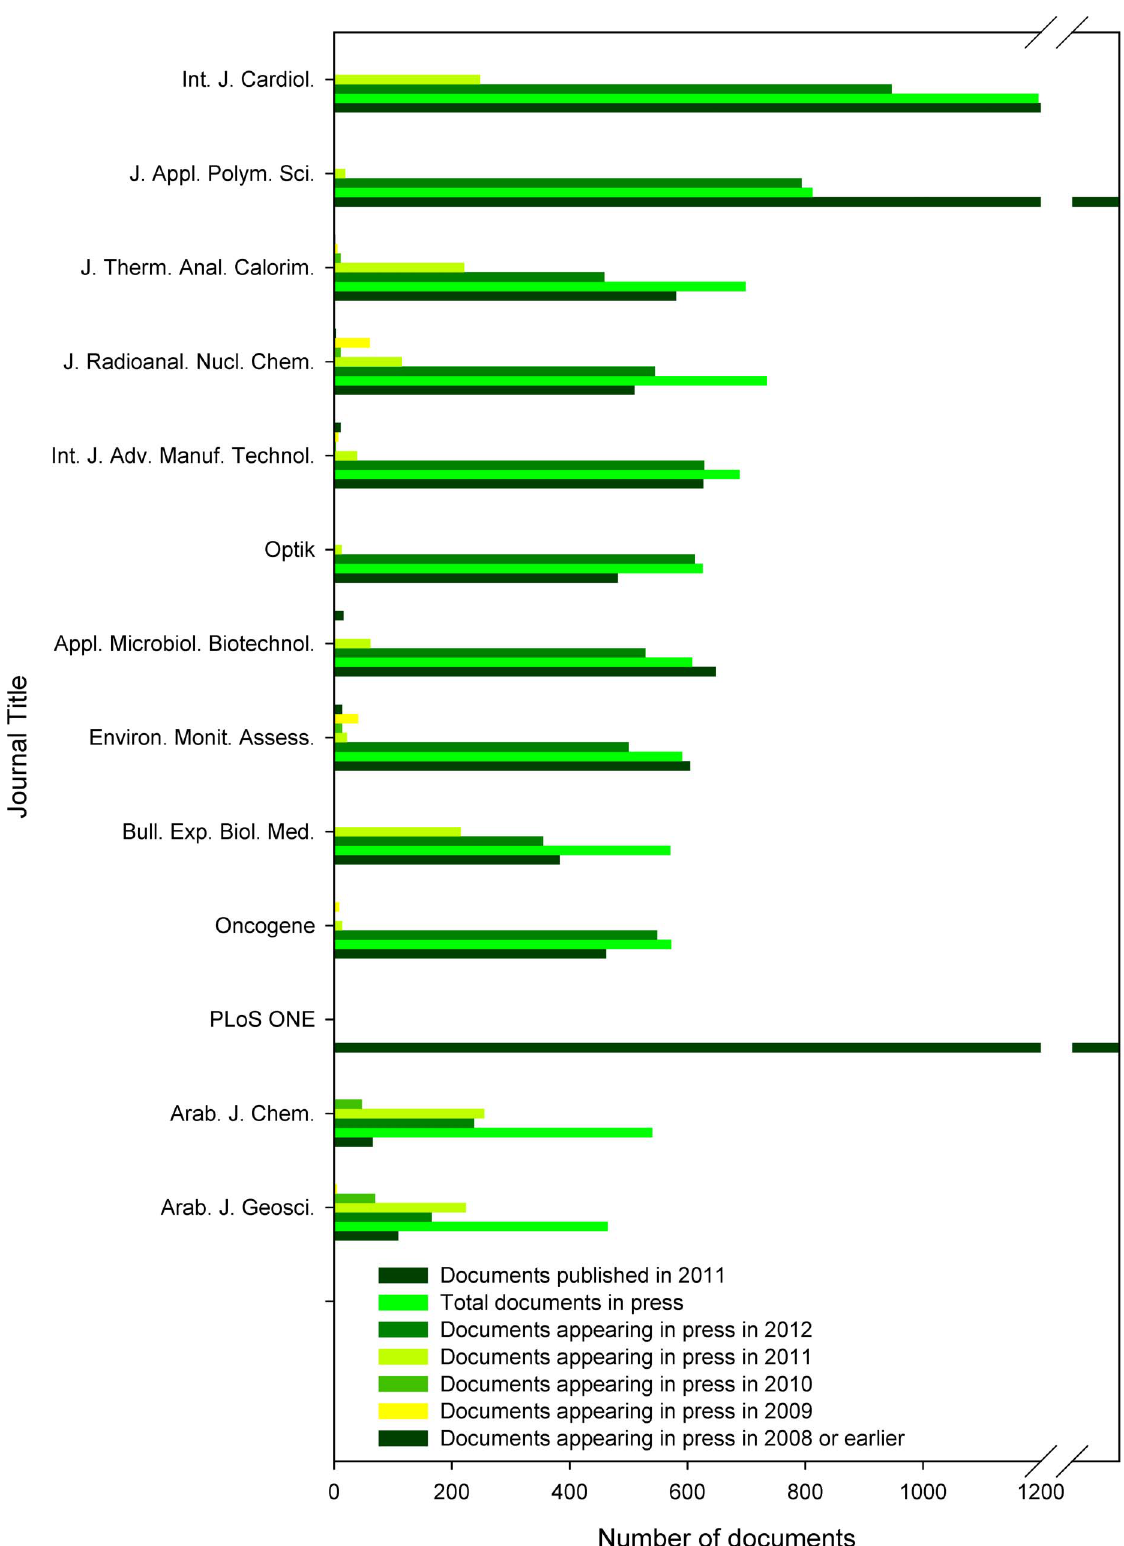
Figure 3. Release dates of documents in press. Indicated are the total numbers of documents published in 2011 (according to Scopus), total numbers of documents in press (according to Scopus), and frequency of release years among documents indicated as in press at the time of analysis (indicated are years 2012, 2011, 2010, 2009, and in 2008 or earlier, all according to Scopus).